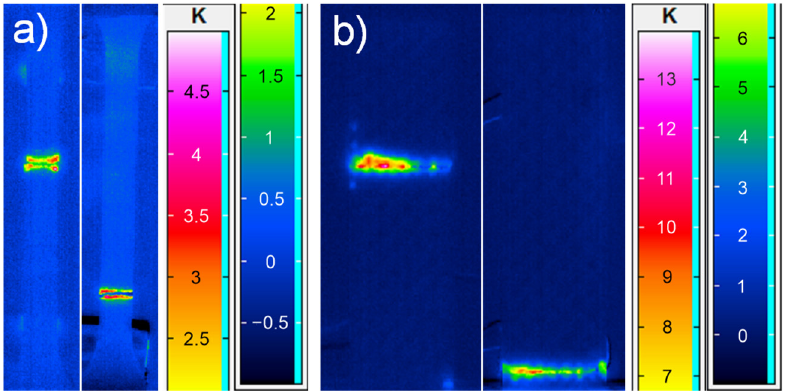
Figure 5. Δ T-thermograms of ( a ) the PPA-GF30 specimens at 23 °C ( left ) and 60 °C ( right ) and ( b ) the CFRP specimens 23 °C ( left ) and 60 °C ( right ) in quasi-static testing. ( b ) the CFRP specimens 23 ◦ C ( left ) and 60 ◦ C ( right ) in quasi-static testing.